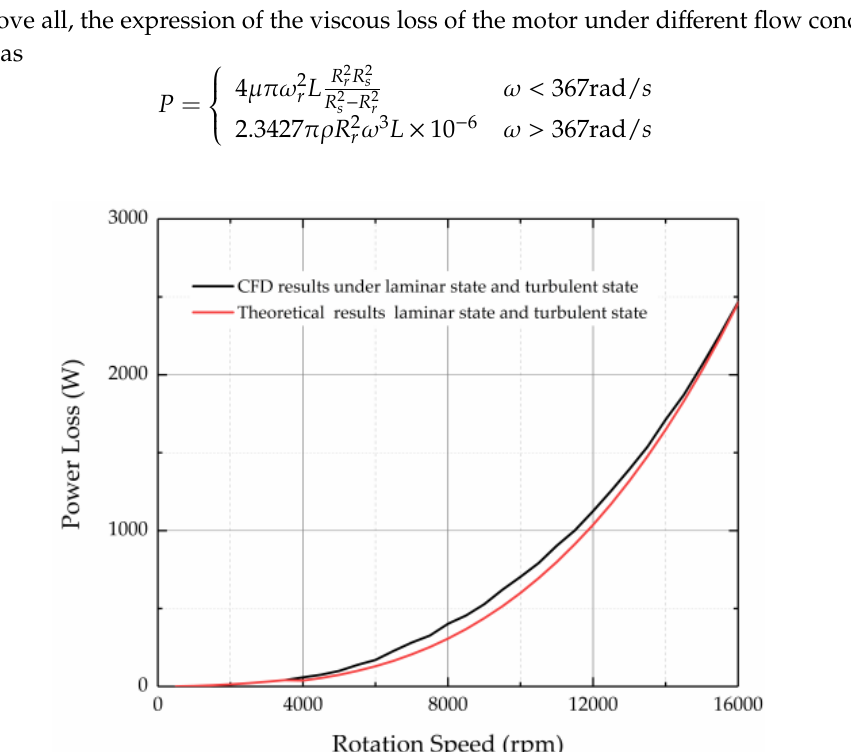
Figure 7. Comparison chart of theoretical results and CFD simulation results under laminar state and turbulent state.